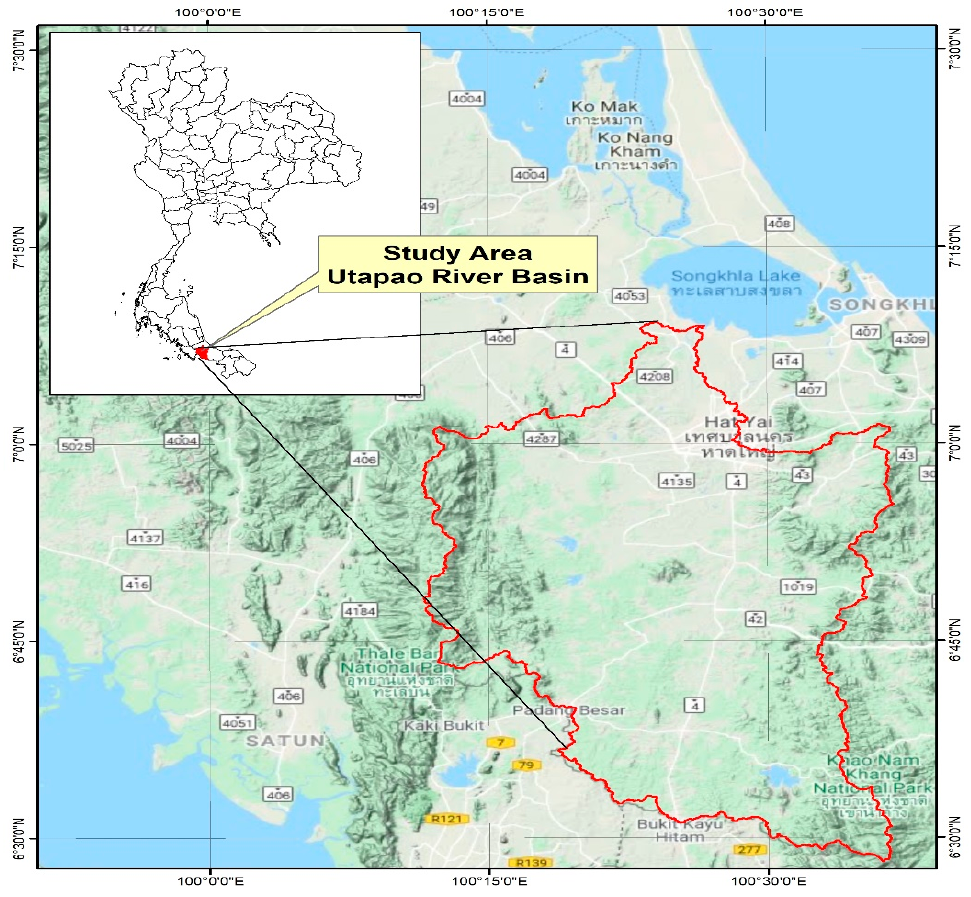
Figure 1. The study area.